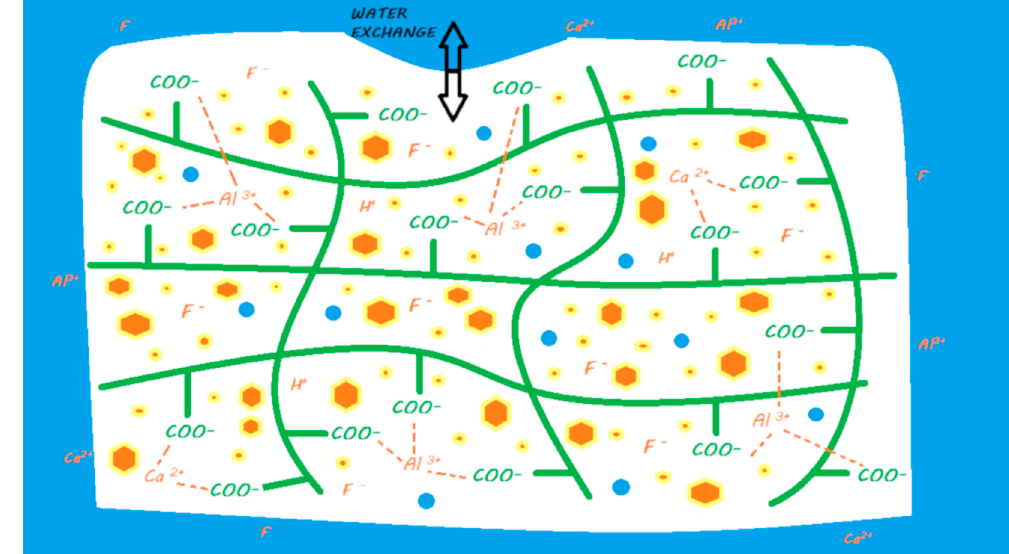
Figure 5. Ion release from an HV-GIC once it is in a moist environment (i.e., an oral environment). The mechanism of the reaction and ion exchange with the oral environment are the same as that previously described for conventional GIC.